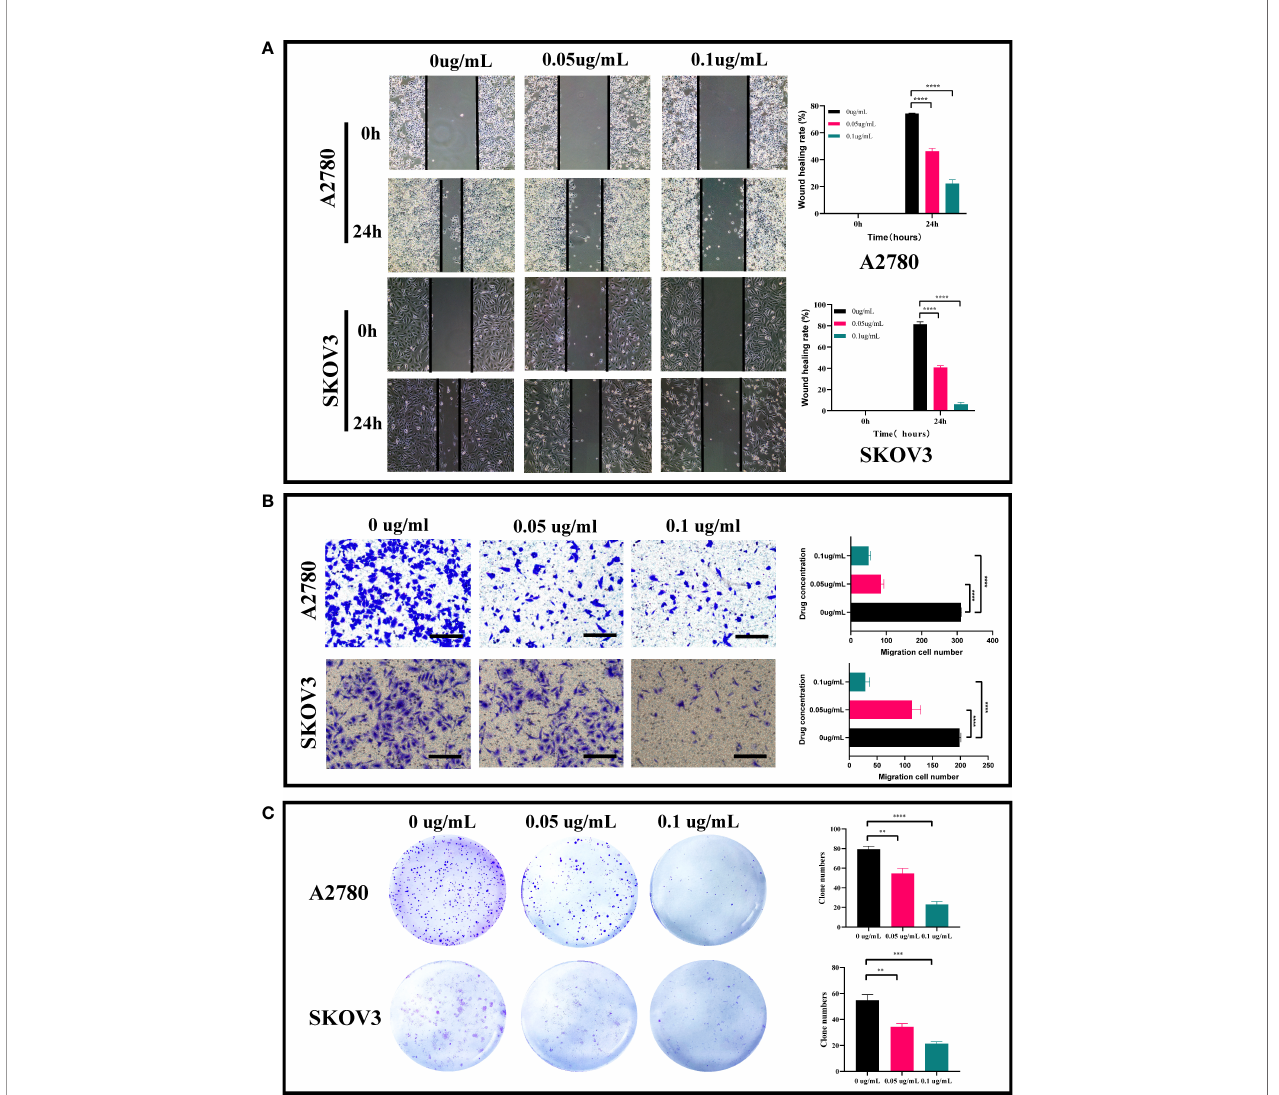
FIGURE 3 | Effect of PEI-Pt NCs treatment on migration and clonogenic ability of ovarian cancer cells. (A) Wound healing assay and analysis results of A2780 and SKOV3 cell lines. Cell migration rates were measured at 0h, 24h and 48h, respectively, and histograms show migration rates. (B) Transwell assay and analysis results of A2780 and SKOV3 cells. cell migration was measured at 24h after 0.05ug/mL and 0.1ug/mL treatment, respectively, and the histograms show the migration rates. (C) Clonogenic assay and analytical results of A2780 and SKOV3 cell lines. The number of clonogenic cell clusters was measured on day 10 after 0.05ug/mL and 0.1ug/mL treatment. (**p < 0.01, ***p < 0.001, ****p <